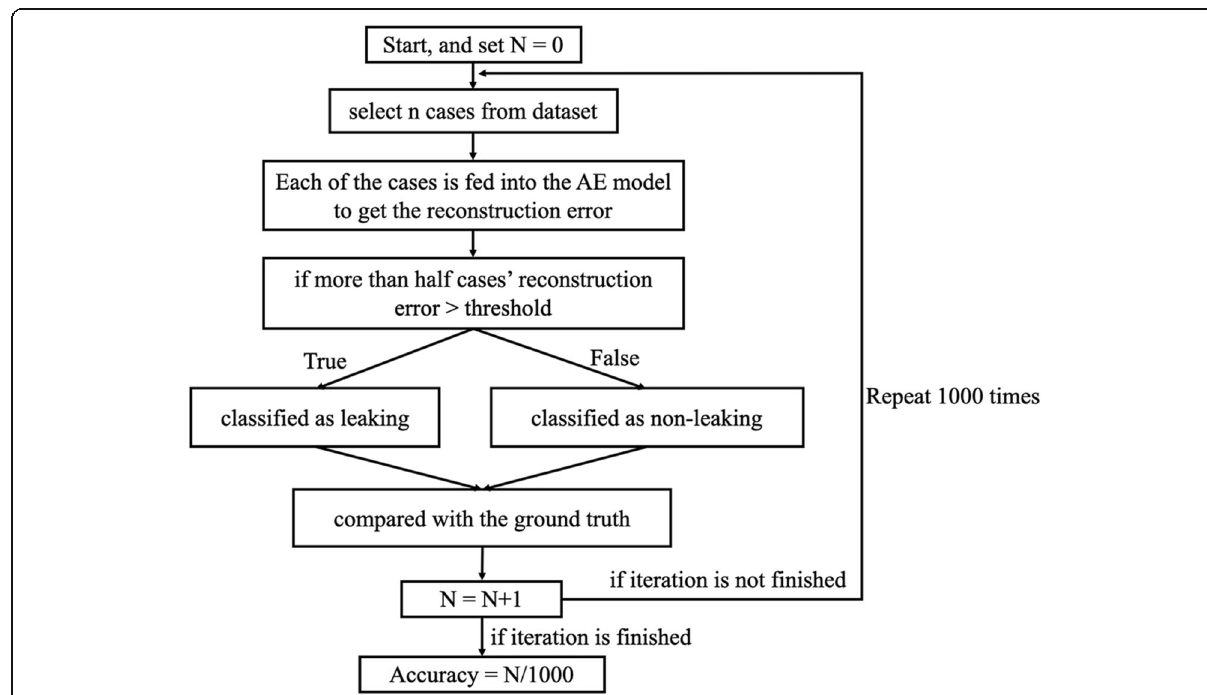
Fig. 13 Flow chart of evaluation process with n